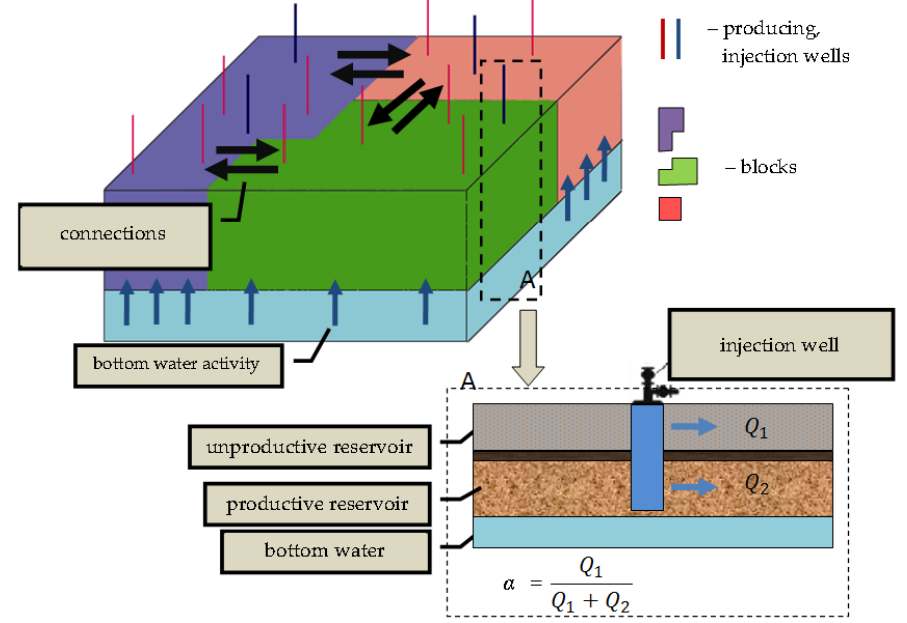
Figure 3. Schematic diagram of an oil field divided into blocks.